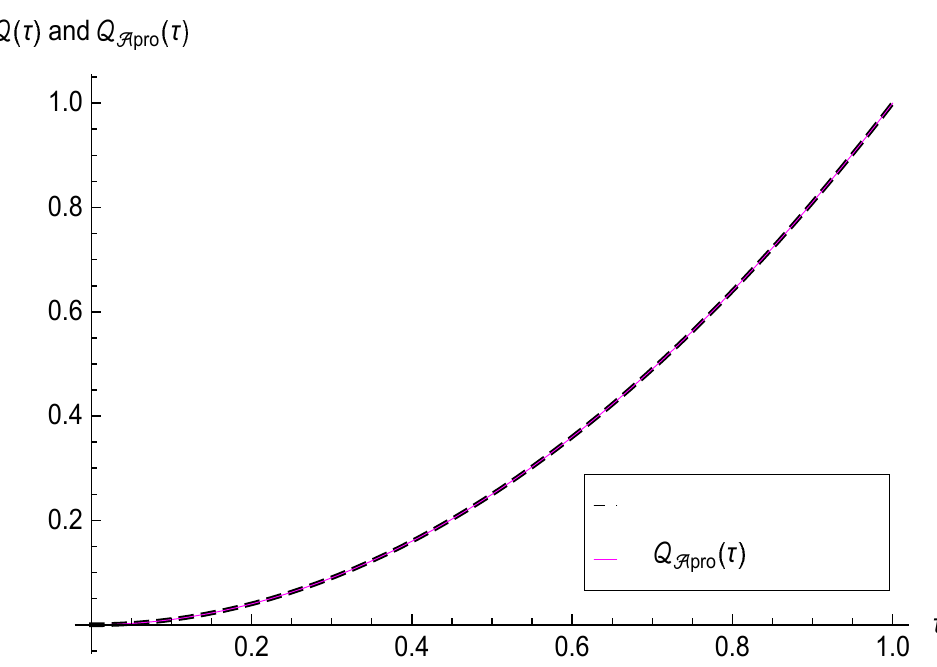
Figure 12. Curves of the exact and numerical solutions of Q ( τ ) of the problem (33), where σ 1 = (cid:36) 1 = σ 2 = (cid:36) 2 = 0, ν = 0.9 and N = M =